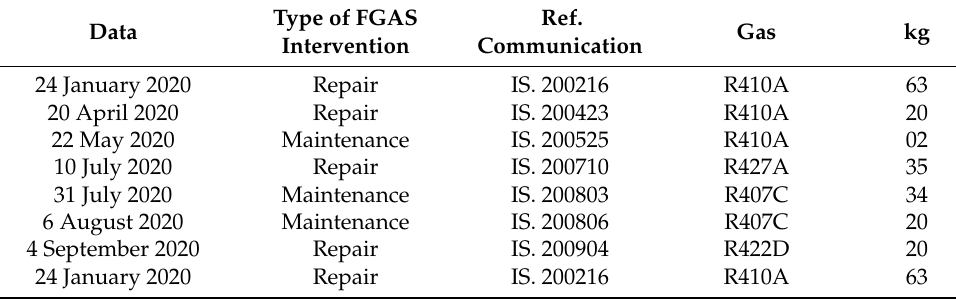
Table 3. Unibo refrigerant gas consumption in